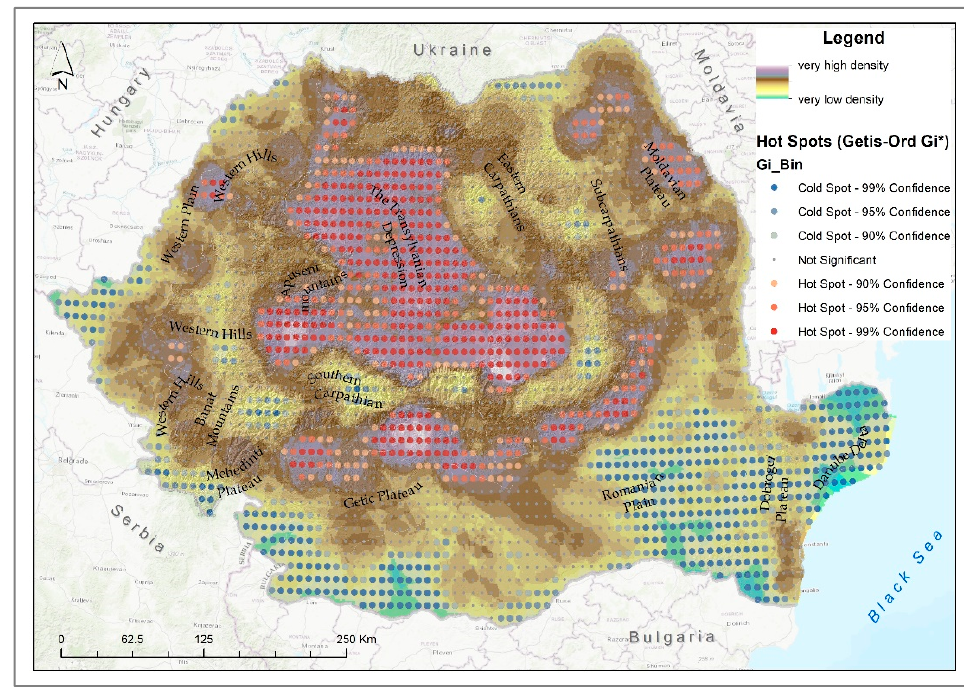
Figure 10. Density of degraded ecosystems and hotspot analysis.